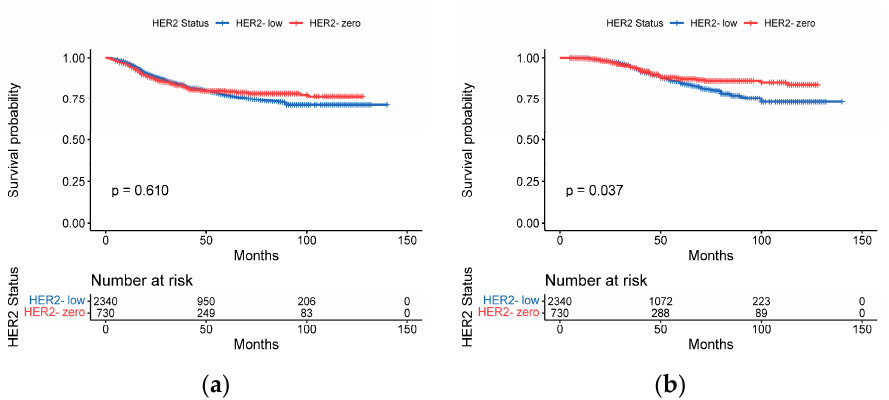
Figure 4. Kaplan ‒ Meier curves for DFS and OS by HER2 status. ( a ) DFS for HER2-zero vs. HER-low ( b ) OS for HER2-zero vs. HER-low.